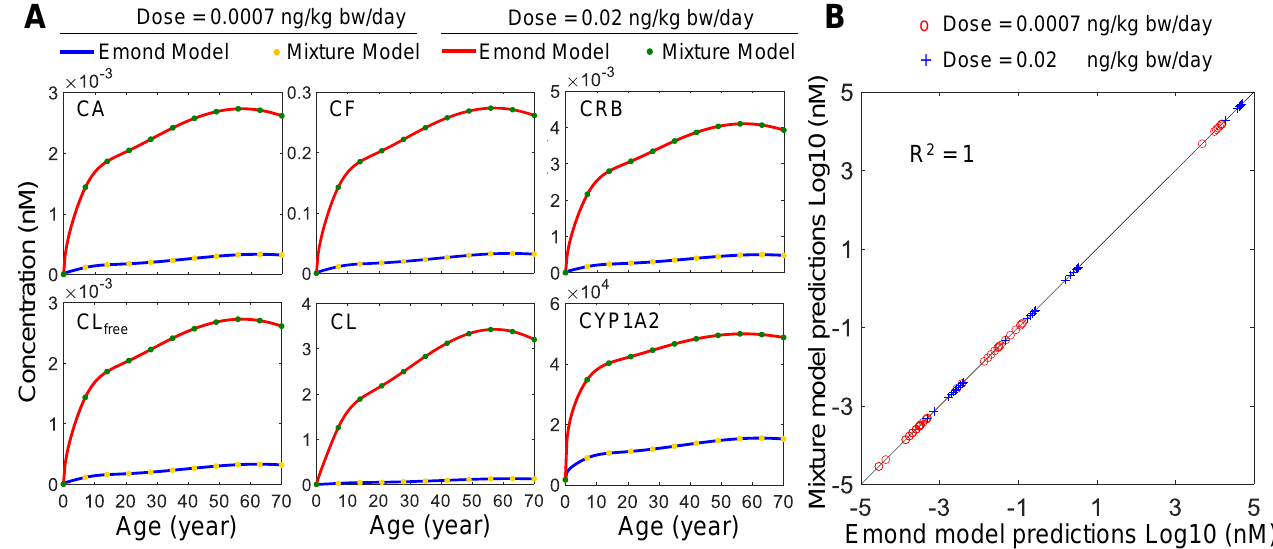
Figure 2. Performance comparison of the mixture model and Emond model . ( A ) Predicted time − course tissue concentrations of TCDD for the Blood ( CA ), Fat ( CF ), RB ( CRB ), and Liver (free: CL free , total: CL ) compartments, and the induced liver CYP1A2 levels for lifetime exposure to two doses by the two models as indicated. ( B ) Scatter plot of Log10-transformed tissue TCDD and CYP1A2 concentrations at select ages (year 1, 10, 20, 30, 40, 50, 60, and 70) predicted by the two models in ( A